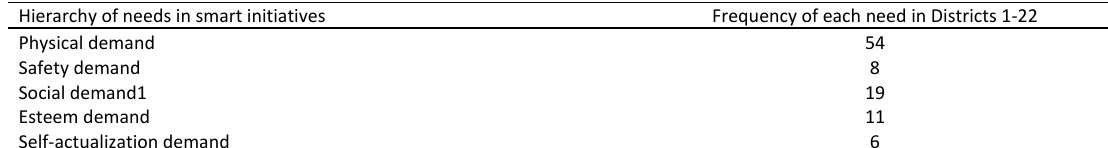
Table 4: The frequency of Tehran smart city projects in the level of the hierarchy of needs